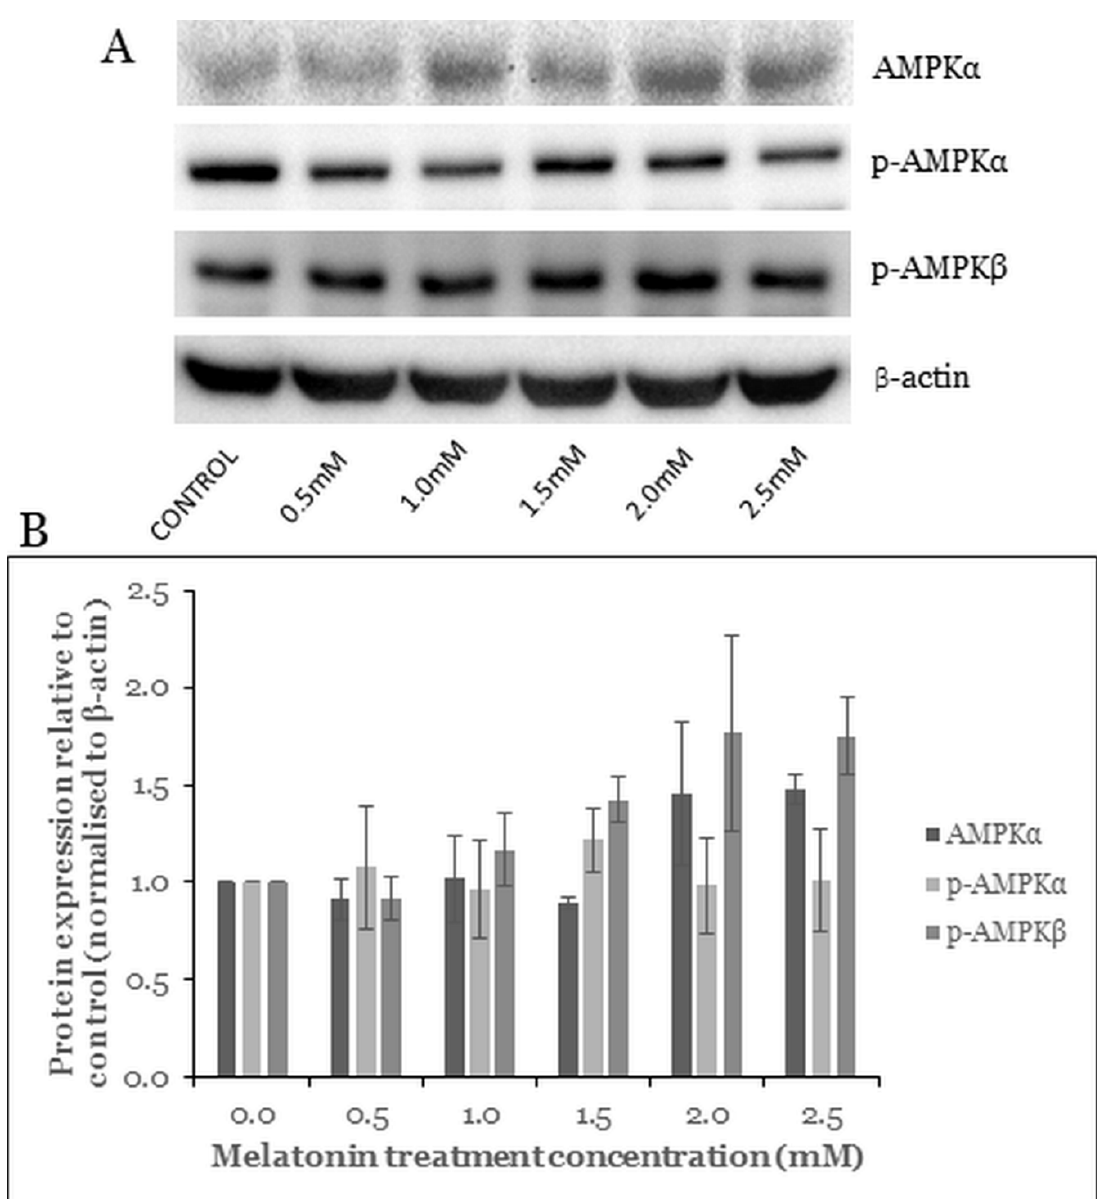
Figure 5. Western blot analysis of the AMPK pathway in HT-29 cells after treated with various concentrations of melatonin for 72 h. ( A ) Expression levels of AMPK proteins were assessed by western blot analysis. ( B ) Bar chart of the protein expressions; each bar represents a mean ± SEM of three independent experiments. One-way ANOVA, followed by Dunnett’s post hoc test, was performed to compare each treatment group with control.